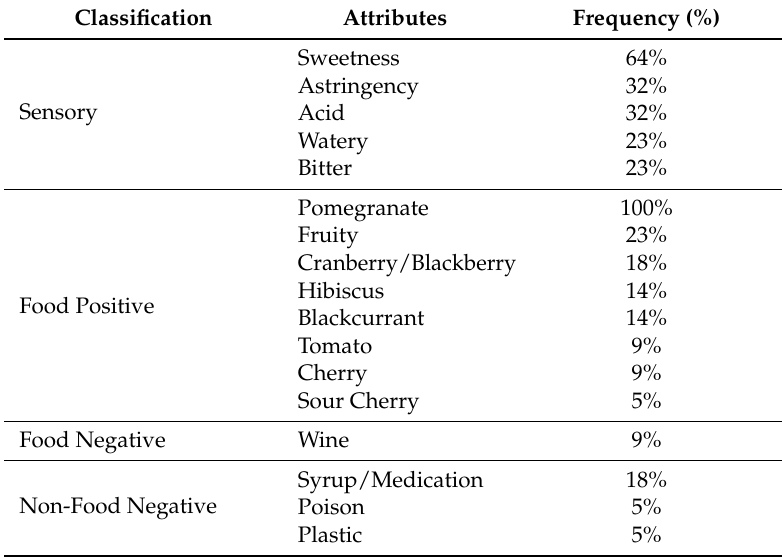
Table 4. Frequency of the attributes generated during the focus groups.